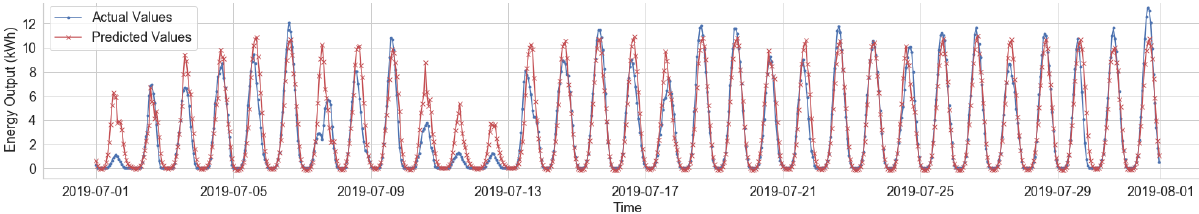
Figure 11: Snapshot of 6-hour predictions for 1 month: July, 2019